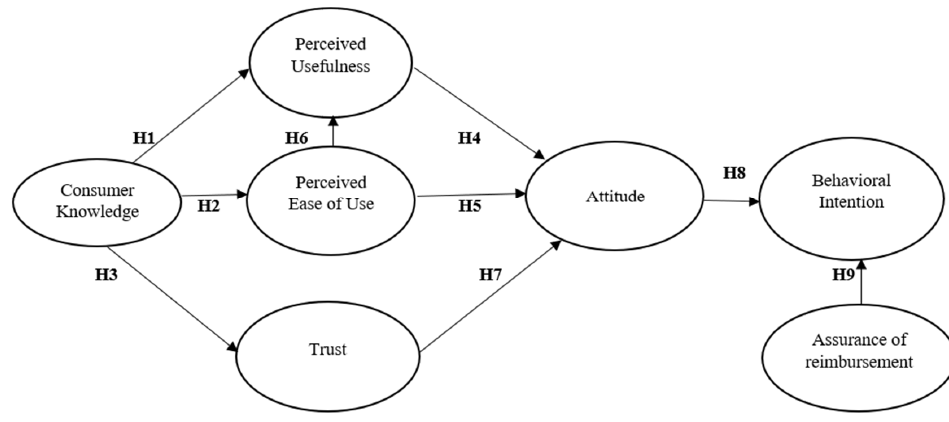
Figure 1. The conceptual